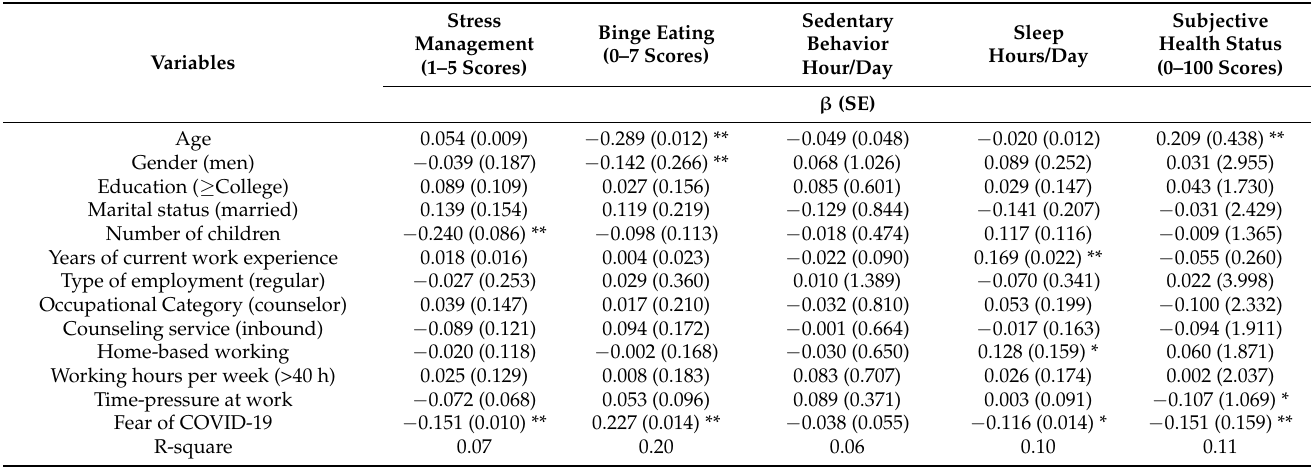
Table 4. Factors for Health Behavior and Subjective